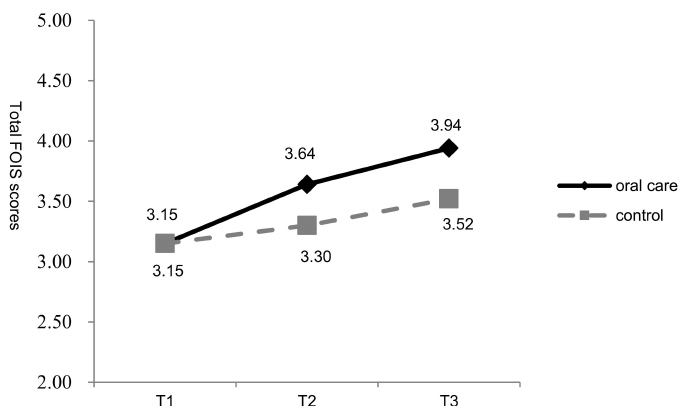
Figure 3. Change in the mean Functional Oral Intake Scale (FOIS) score in the two groups at three time points (T1–T3).